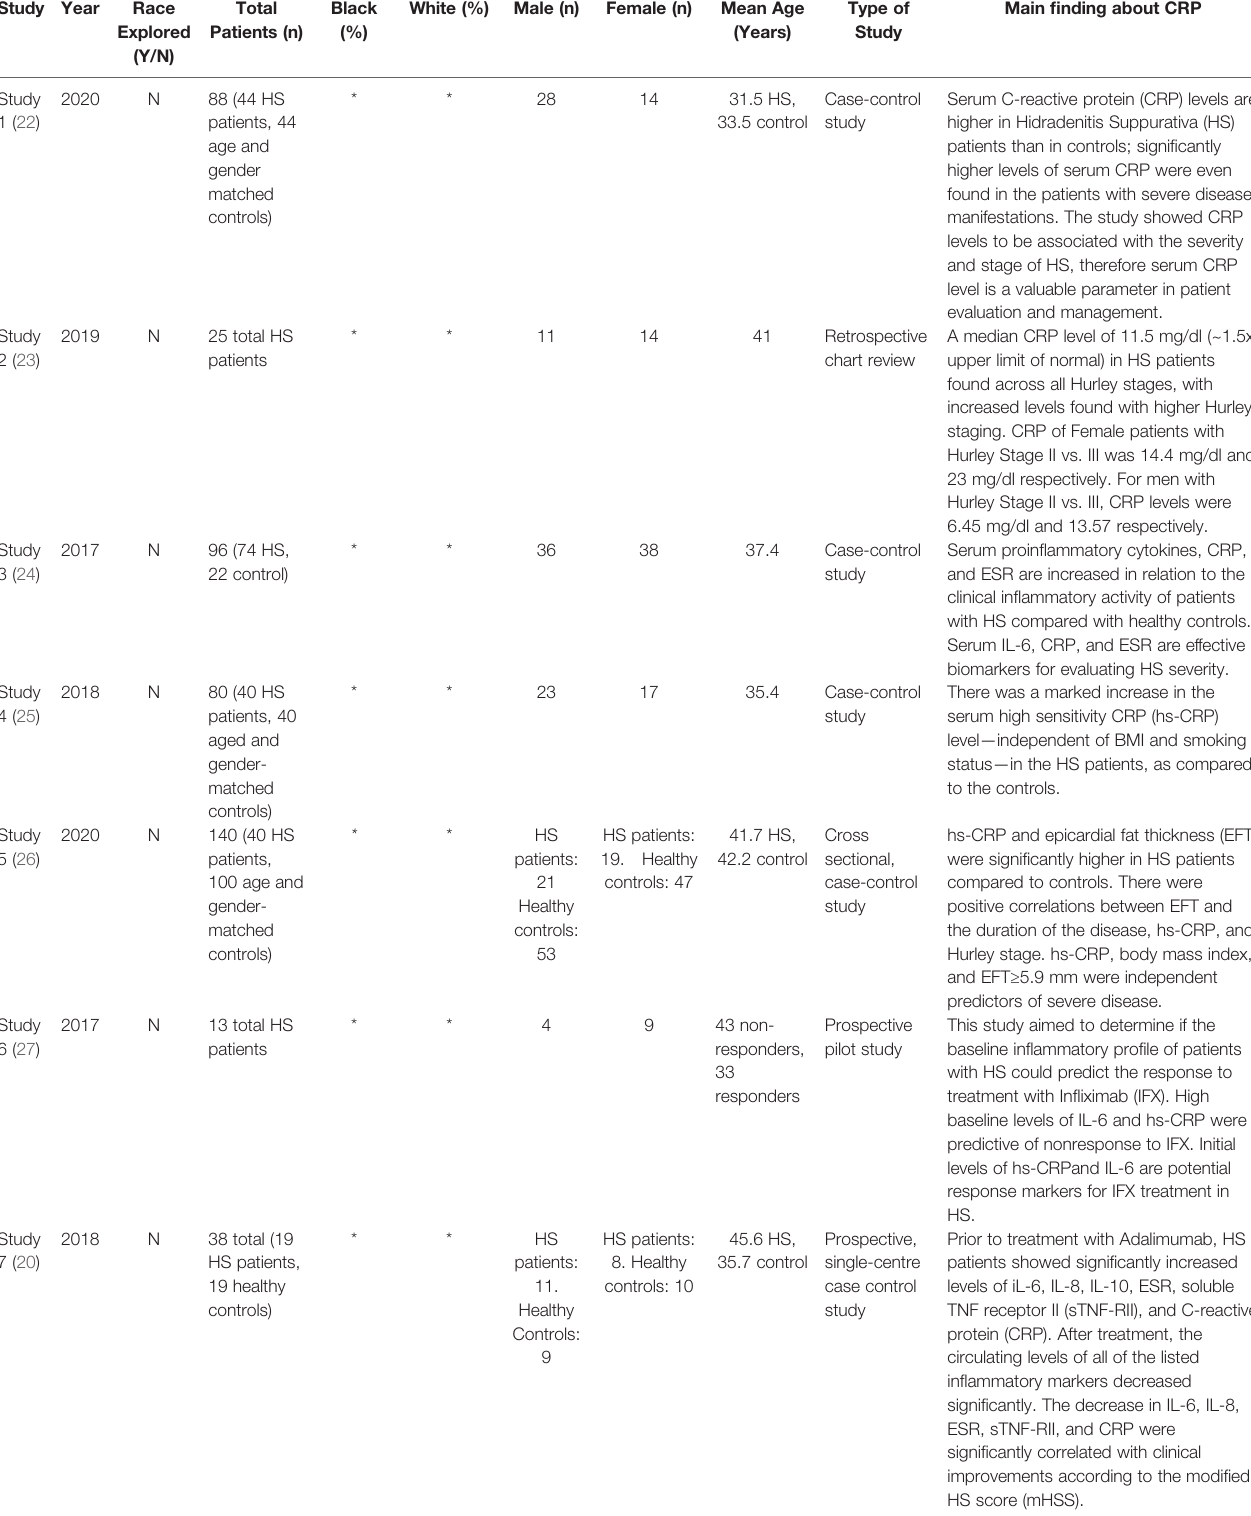
TABLE 1 | Summary of studies exploring HS and